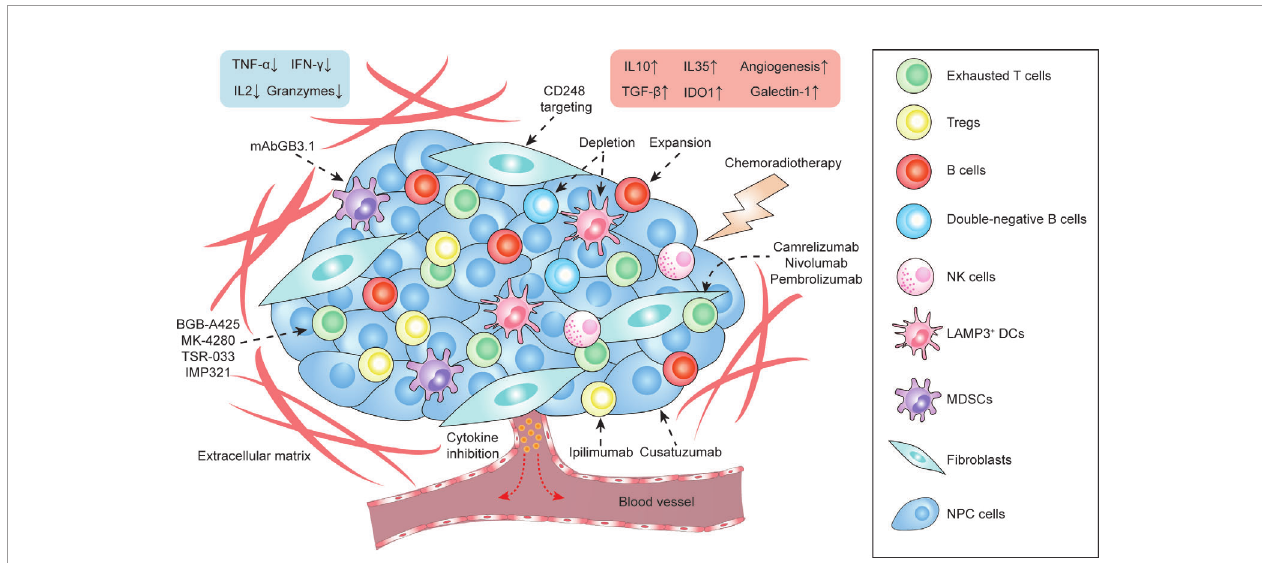
FIGURE 3 | The stromal landscape of NPC at a glance and proposed treatment strategies targeting TME-in fi ltrating